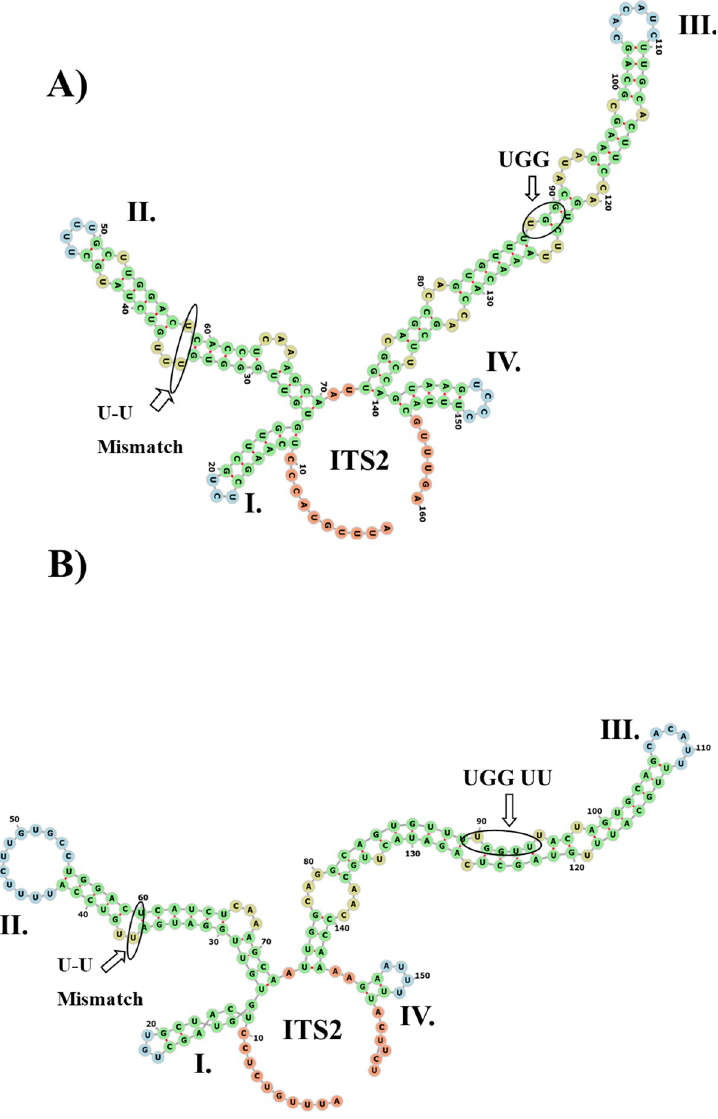
Fig 4. Common features of the ITS2 S2 from Ampelomyces . (A) The ITS2 S2 from Ampelomyces extracted from seven PM genera. The ITS2 contained a core structure with four helices (I–IV), a U-U mismatch on helix II and a large helix III containing a UGG motif. (B) This ITS2 S2 was found in Ampelomyces sampled in China (GI: DQ490752). The UGGU and UU motifs were located in helix III. The minimum free energy structures were calculated with RNAfold and visualized using a force directed graph layout with the Vienna RNA Web Services [64]. The helices are indicated with Roman numerals (I–IV). The U-U mismatch on helix II and the UGG, UGGU and UU motifs are indicated with